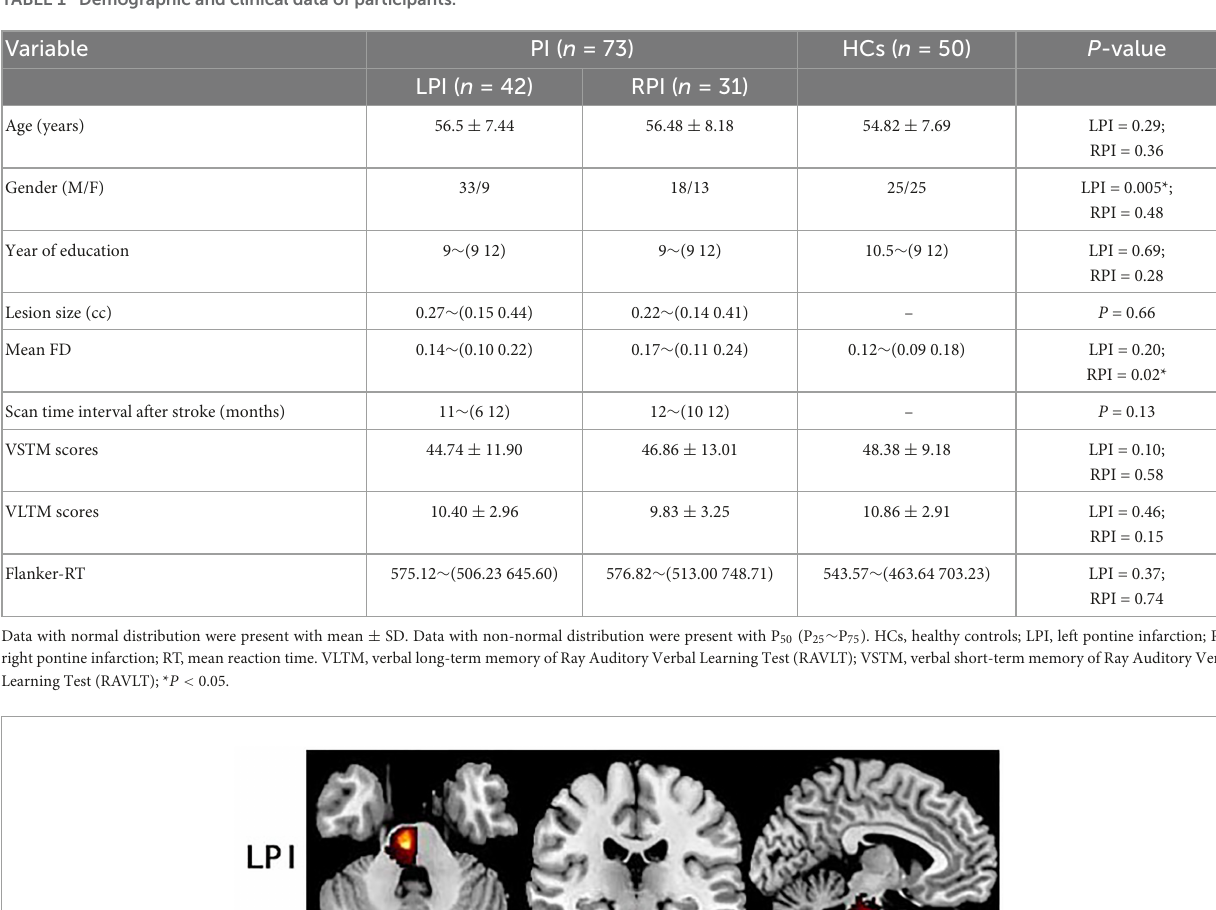
Dynamic ALFF and dynamic